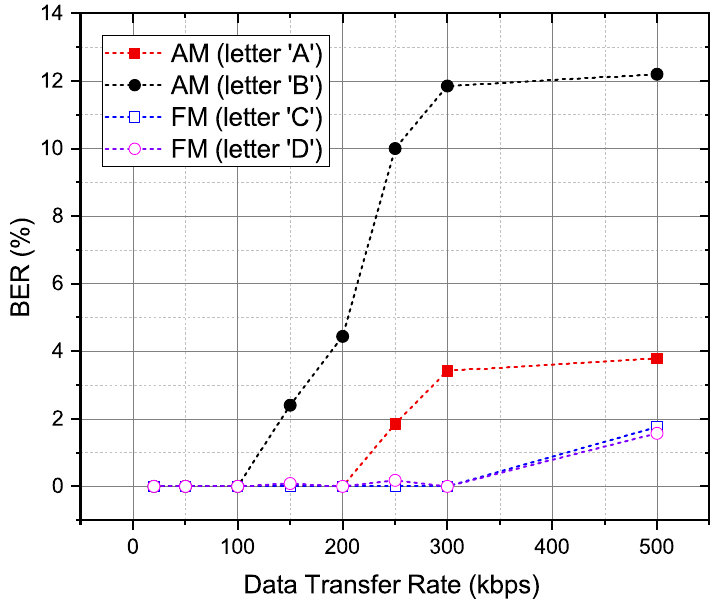
Figure 6. Bit error ratio (BER) for image data reception at different